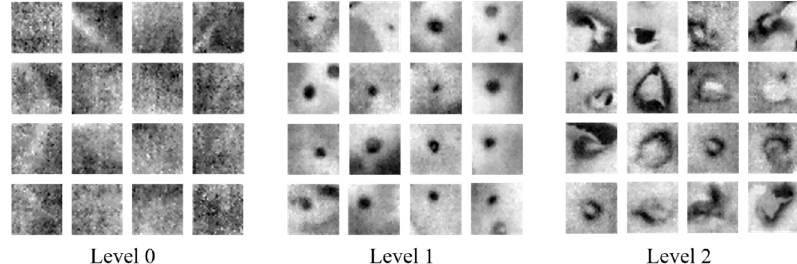
Figure 7. Three disease severity levels: Level 0 for healthy samples, Level 1 for mild infected samples and Level 2 for severe infection samples.